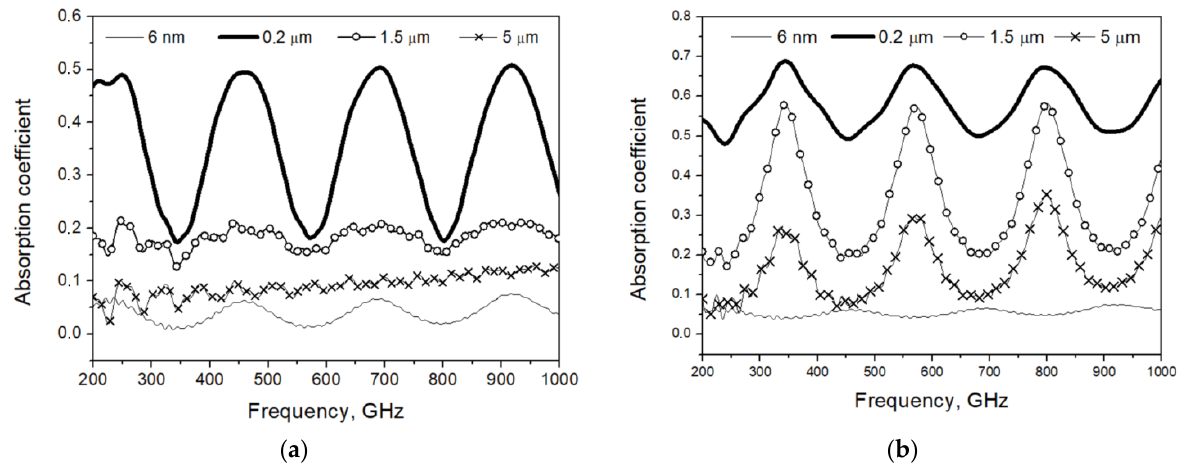
Figure 5. Calculated absorption coefficient of films with different thickness. Irradiation from ( a ) film side and ( b ) substrate side.